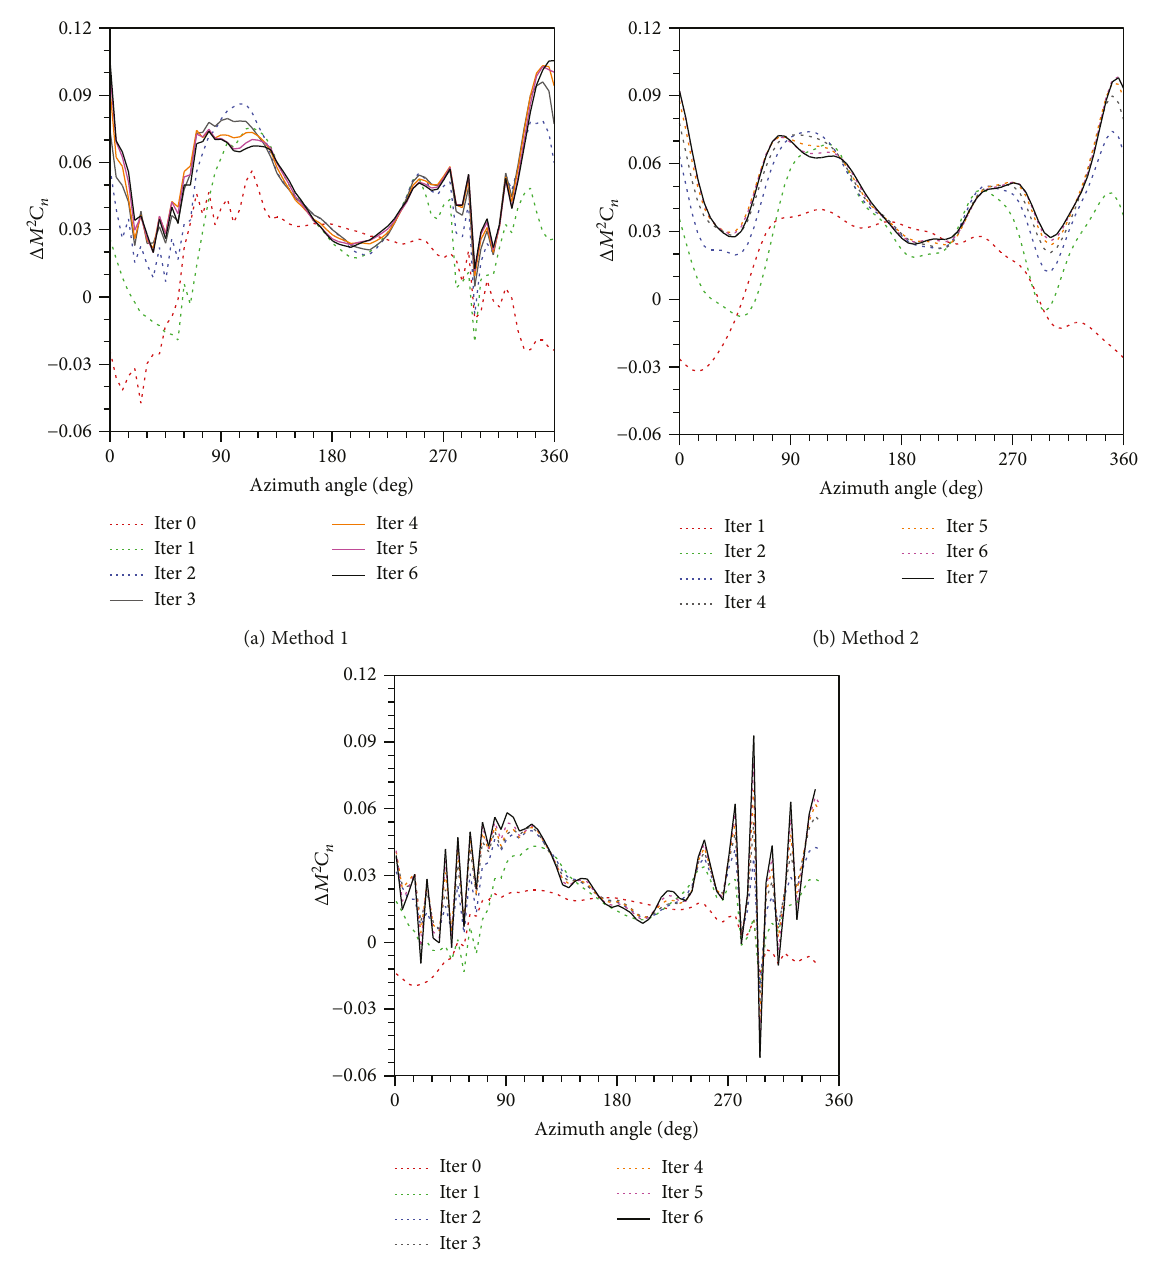
Figure 7: Comparison of convergence on delta airloads Δ M 2 C